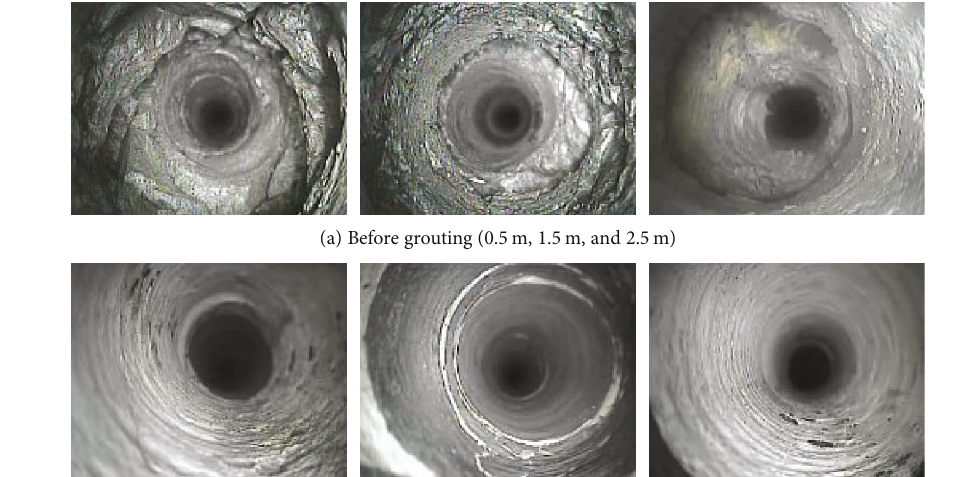
Figure 11: Borehole